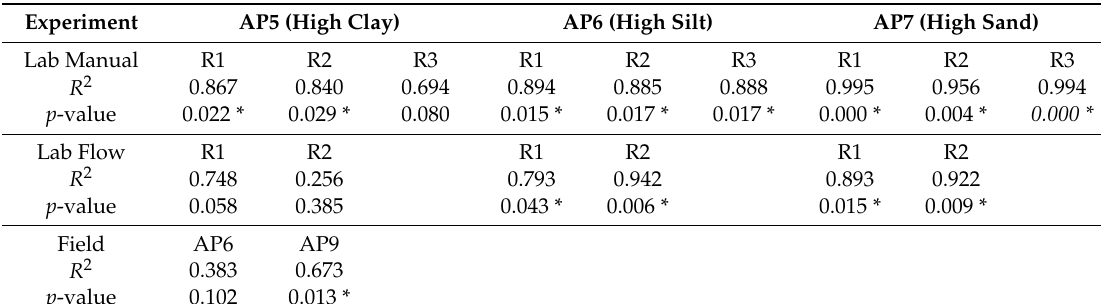
Table 1. Correlation coefficients and significance values for the regression analysis between E. coli and turbidity in the laboratory and field experiments.